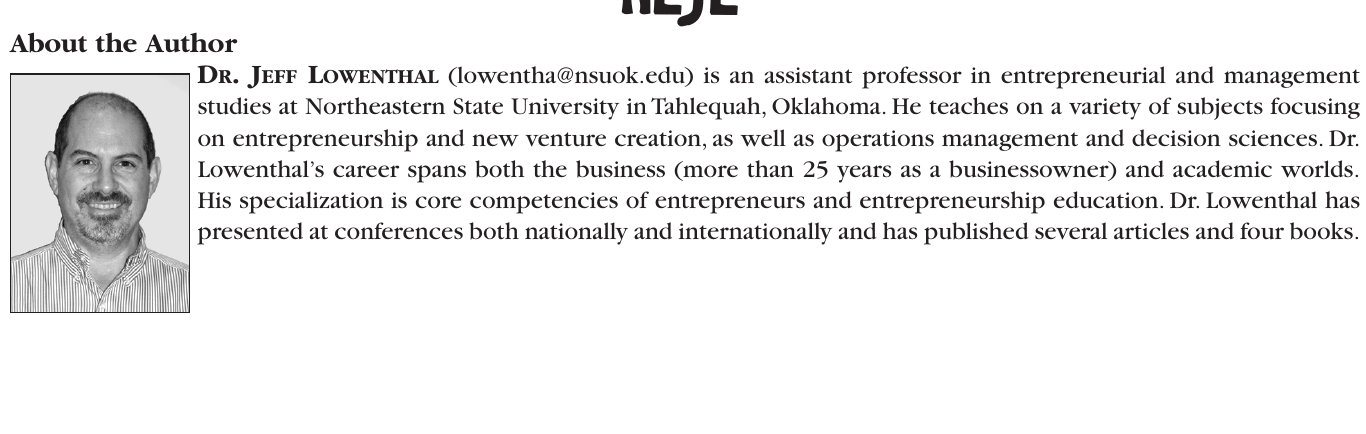
Percentage of change is not included in the report and must be manually